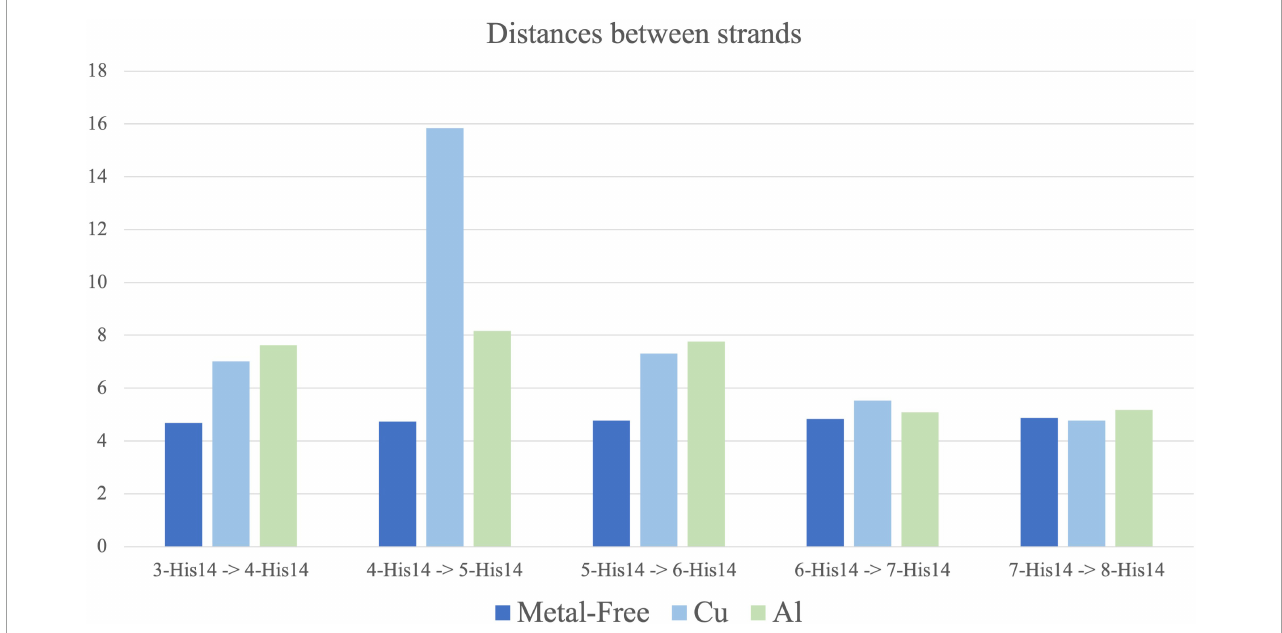
FIGURE7 Average distance between His14 from each core strand to the adjacent one along 100 ns molecular dynamic (MD) simulation for metal-free fibril (dark blue), Cu(II) (light blue) and Al(III) (green). Standard deviation range from 0.1 to 0.7. Strands 3–4, 5–6, and 7–8 are bound by metal coordination in Cu(II) and Al(III) systems.